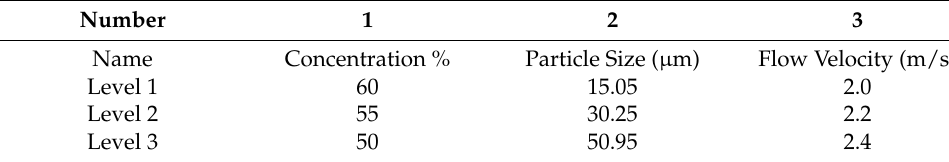
Table 3. Factor and level chart.